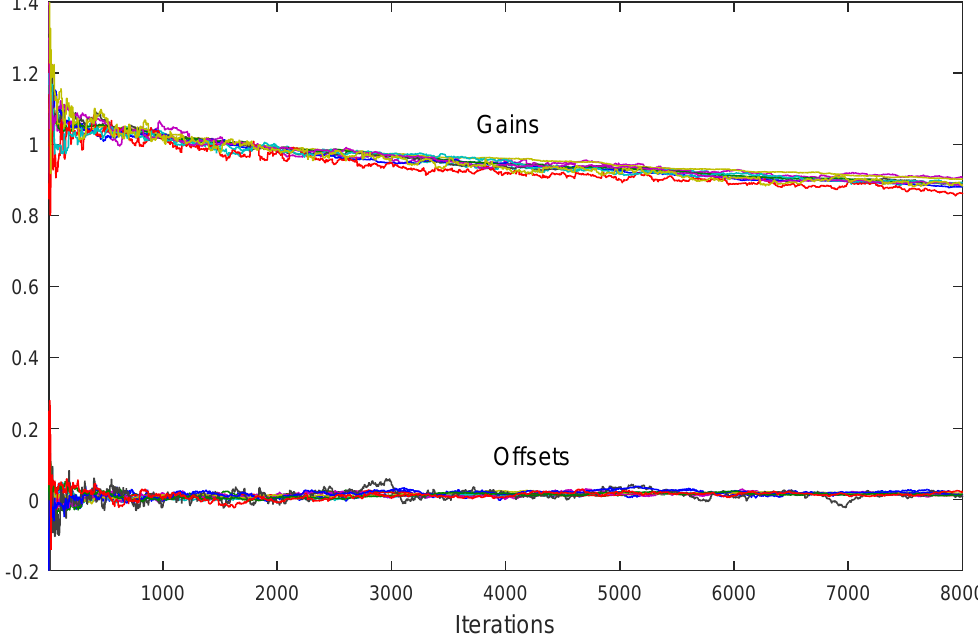
Figure 7. Stochastic gradient algorithm: convergence to consensus is not